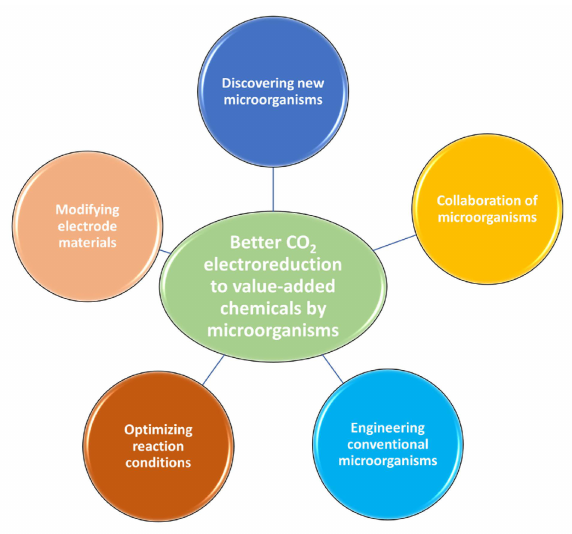
Figure 2. Strategies for the enhancement of the electrochemical reduction of CO 2 to produce value- added